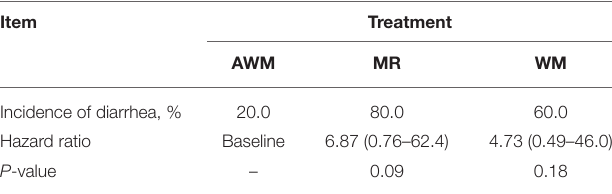
TABLE 4 | Incidence of diarrhea up to 15 days relative to birth date in calves fed with different liquid diets.